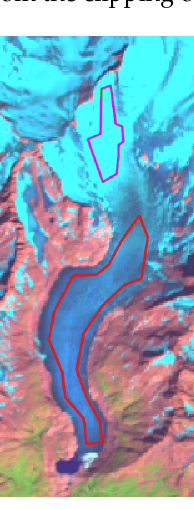
Figure 4. Example of a Landsat 8 scene used to build our data set. For each scene, snow and ice areas are designated with shape files (here illustrated with the red polygons) hand-edited from a false color Green/NIR/SWIR representation. The light blue area (top of the image) is snow, and the darker area (bottom of the image) is